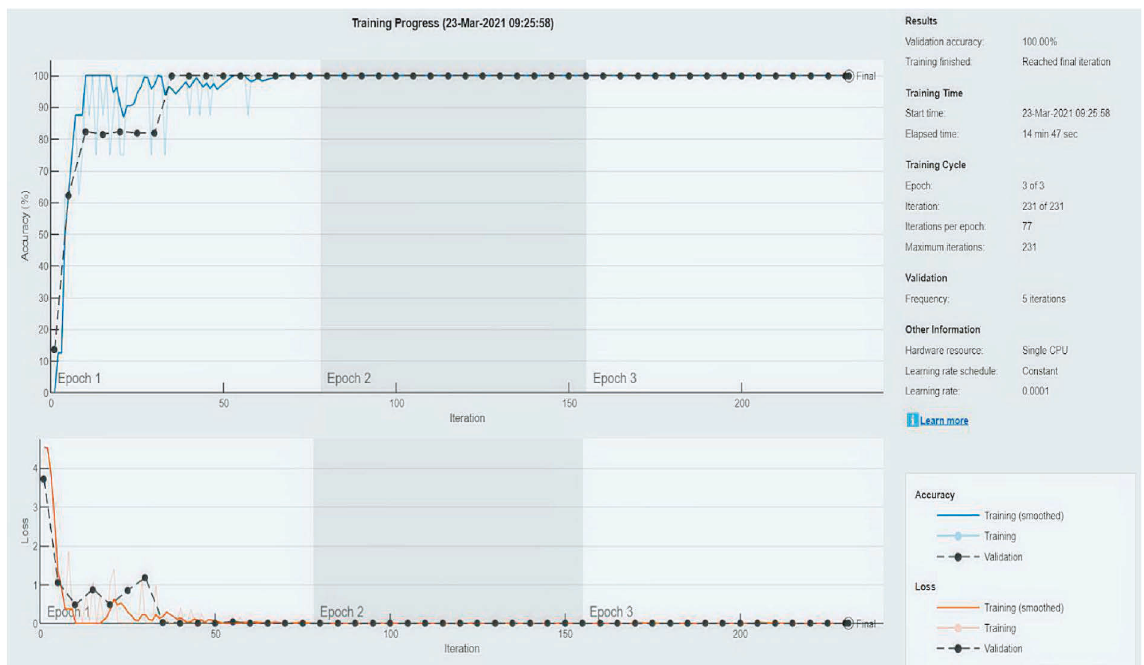
Figure 9: Training progress of finely tuned